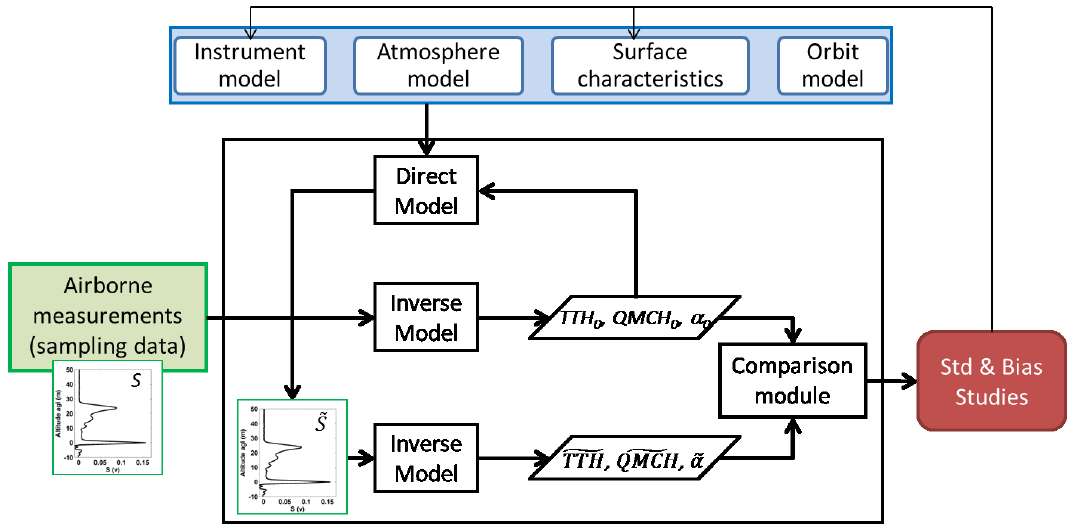
Figure 2. Block diagram of the end-to-end simulator. Both the standard deviations and the bias of the tree top height ( TTH ), the quadratic mean canopy height ( QMCH ) and the extinction coefficient (α) are computed using a Monte Carlo approach. TTH 0 , QMCH 0 and α 0 are initial values derived from the real lidar signal S . 𝑇𝑇𝐻̃ , 𝑄𝑀𝐶𝐻̃ and 𝛼̃ are estimated values derived from the simulated lidar profile 𝑆̃ for each statistical